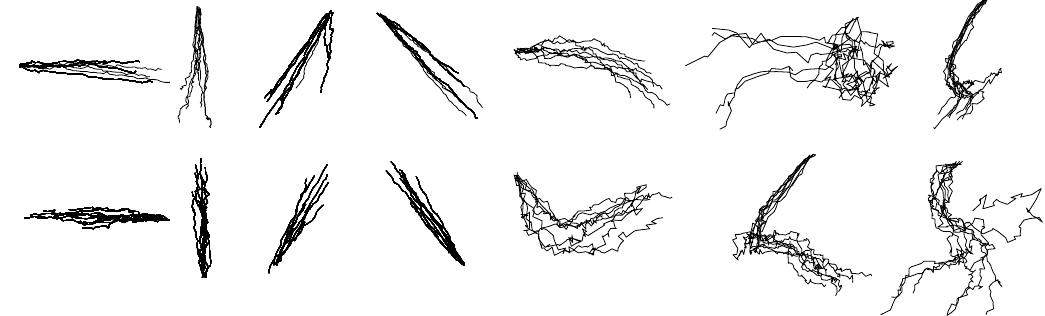
Figure 13. The randomly selected reconstructed drawing traces of within-group reconstruction by the GEP.